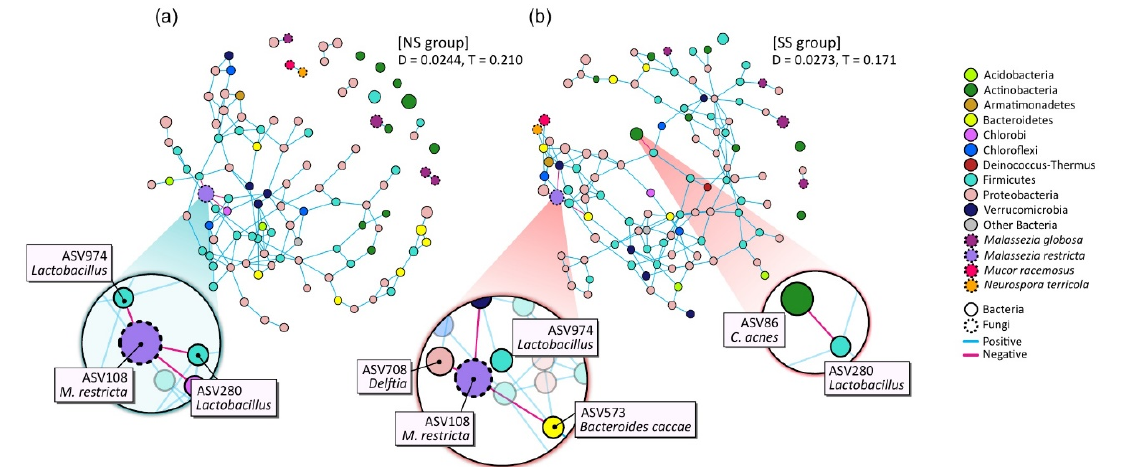
Figure 4. Network analysis of combined bacterial and fungal ASVs based on 50% frequency in ( a ) NS and ( b ) SS groups. Each node represents an ASV and is colored according to bacterial phylum or fungal species level. Edge color denotes whether two connected ASVs are in a positive or negative interaction. The prominent ASVs and main interactions are shown enlarged on the plot. D: density of edge; T: transitivity (clustering coefficient).